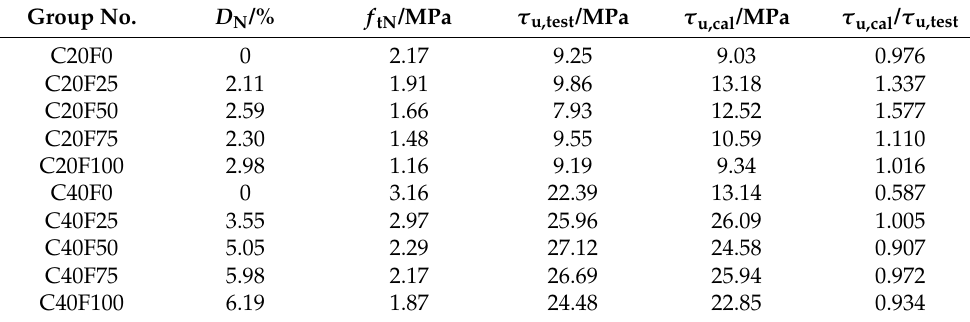
Table 4. Calculation and experimental values of bond strength.